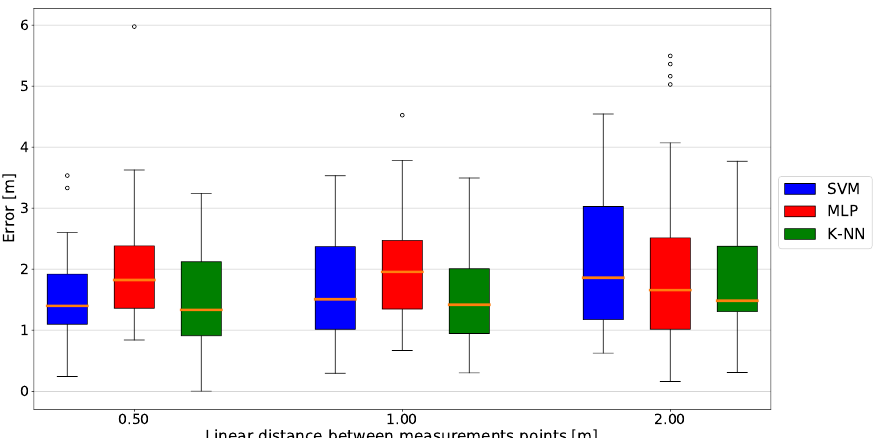
Figure 8. Error box plots for the three fingerprinting algorithms with different fingerprint grid densities in Environment A.